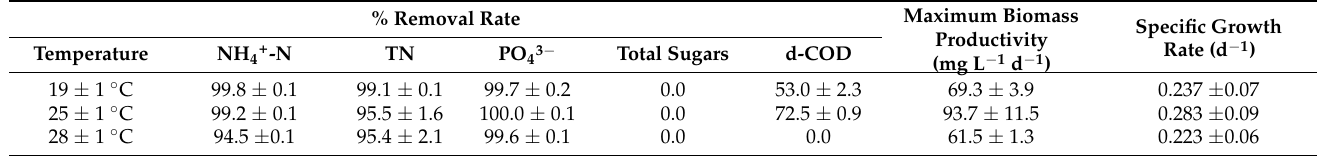
Table 8. Nutrient reduction rates, biomass productivity and specific growth rates achieved at experimental sets for optimum temperature investigation.